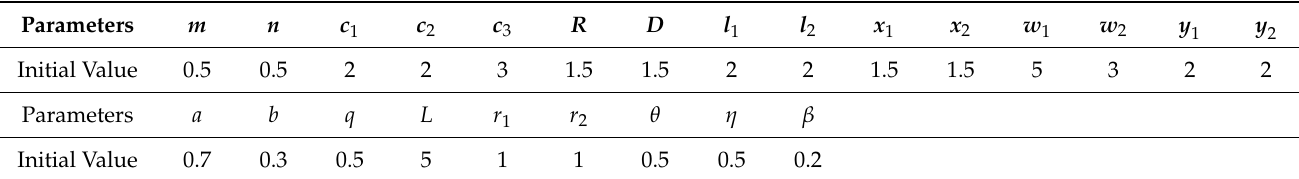
Table 7. Parameter